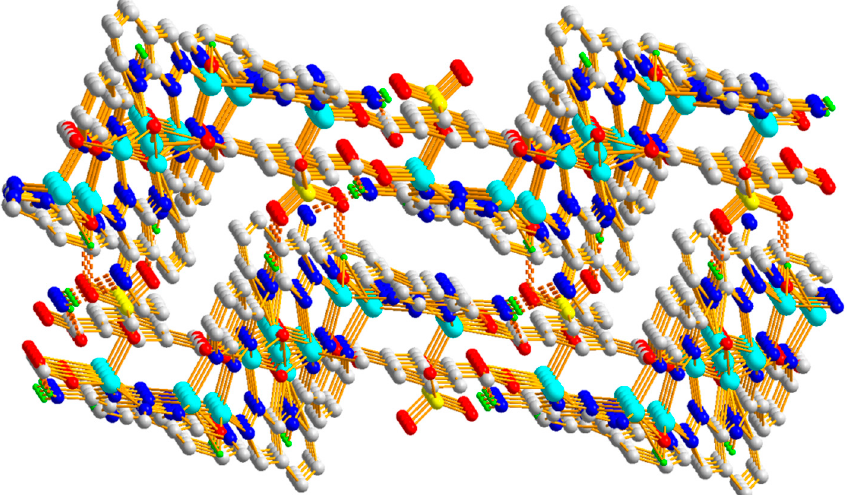
Figure 13. The 3D supramolecular network of Polymer 3.